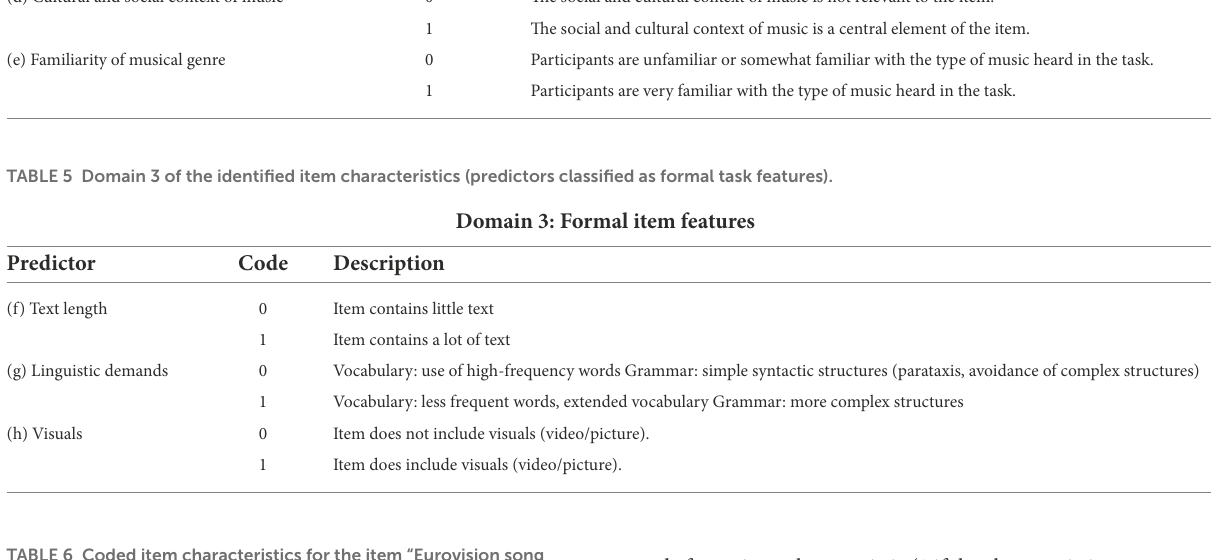
TABLE 6 Coded item characteristics for the item “Eurovision song contest.” Domain 1 Cognitive requirement